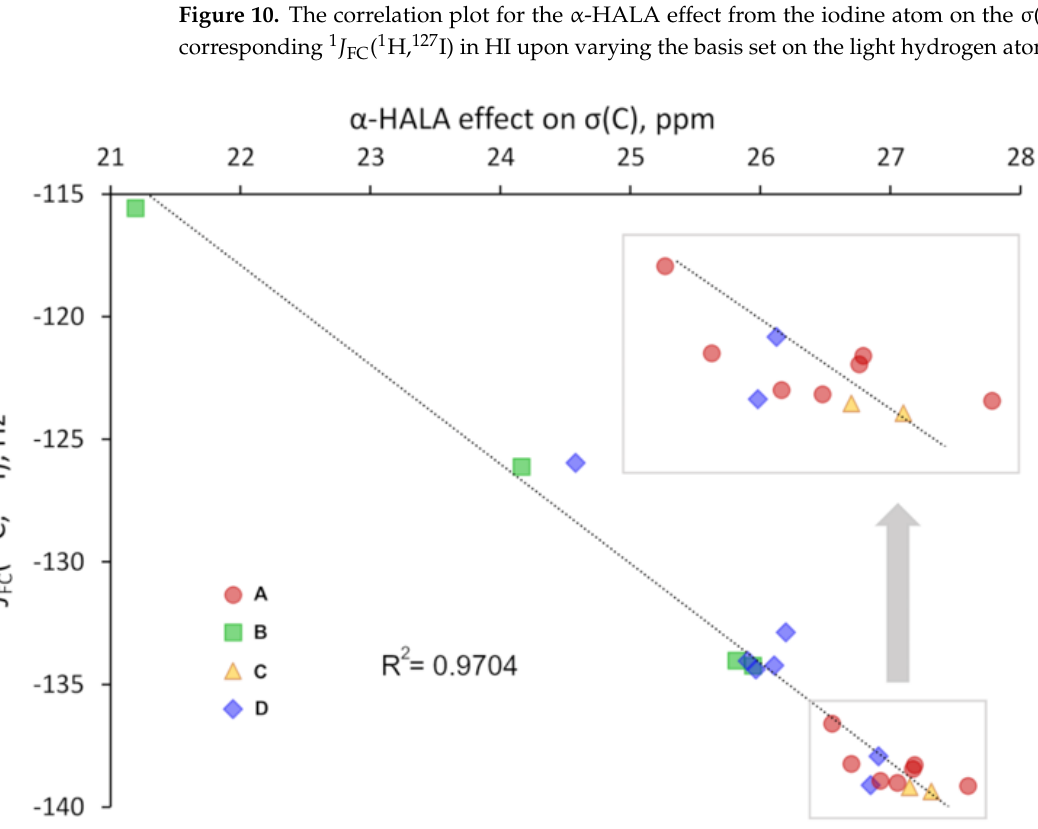
Figure 11. The correlation plot for the α -HALA effect from the iodine atom on the σ ( 13 C) and the corresponding 1 J FC ( 13 C, 127 I) in I-CH 3 upon varying the basis set on the carbon